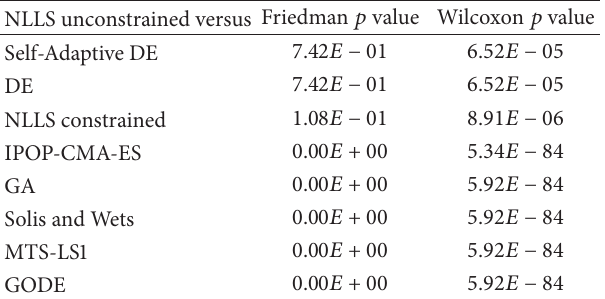
Table 22: Corrected 𝑝 values according to Holm’s method (IPOP- CMA-ES is the control algorithm) for all the